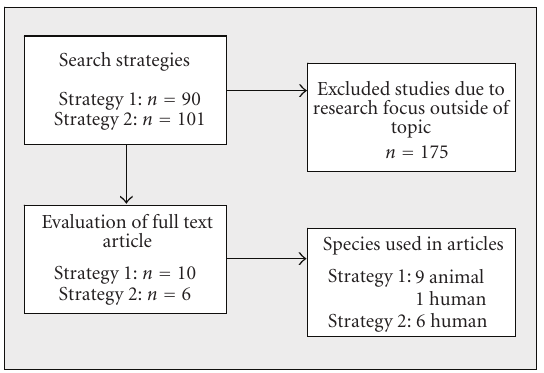
Figure 2: Flow-chart describing the process of selection and identification of